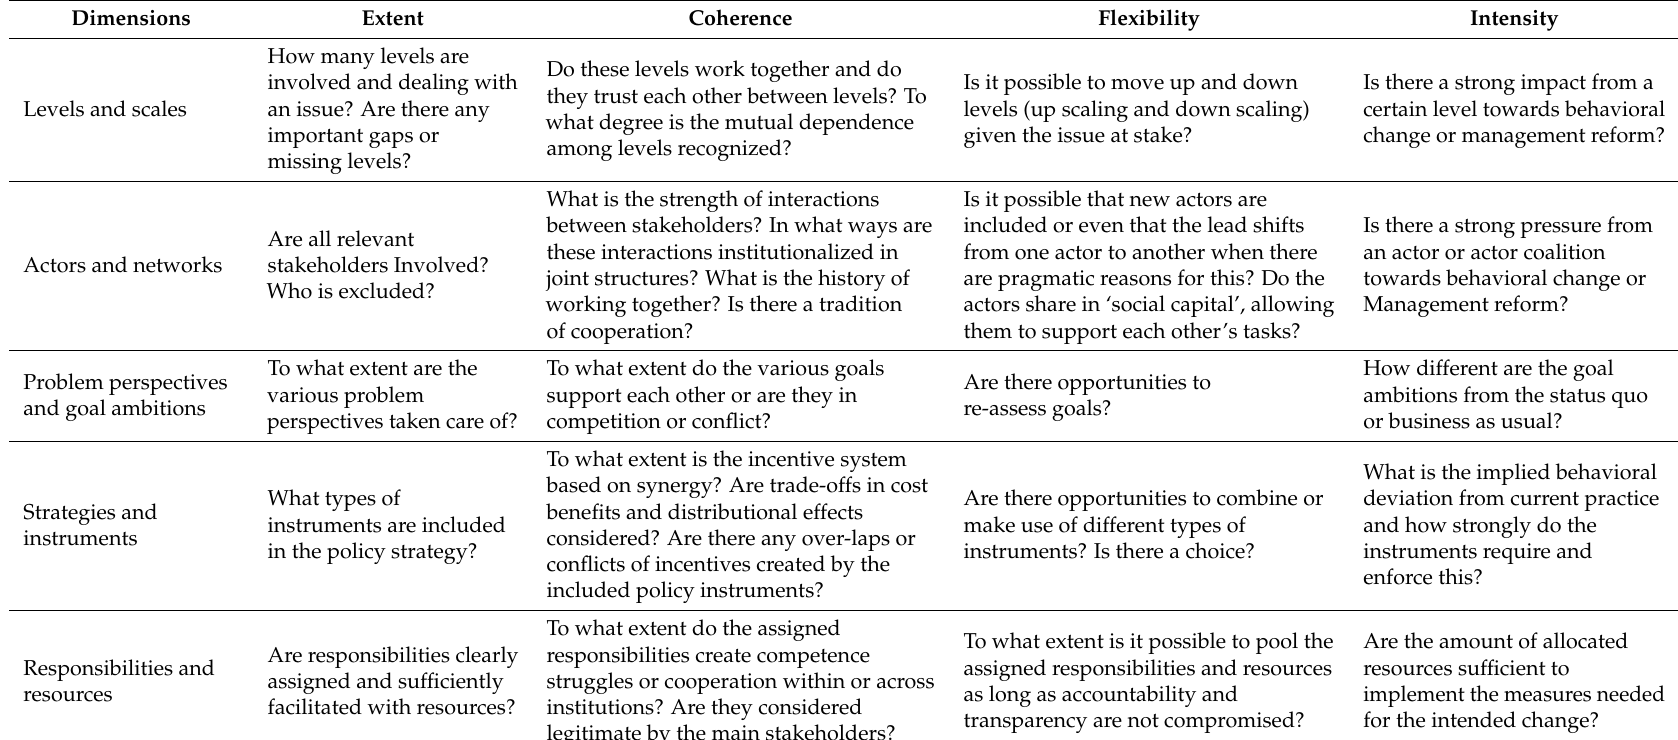
Table 1. Matrix of the Governance Assessment Tool (adapted from: